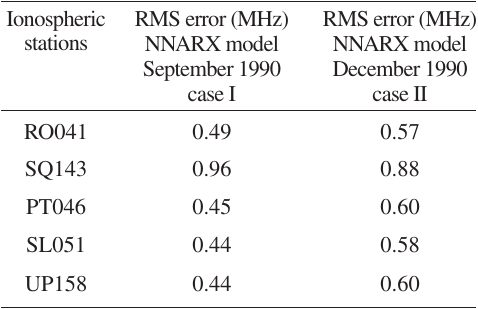
Table IV. RMS errors at different stations for Sep- tember and December 1990.